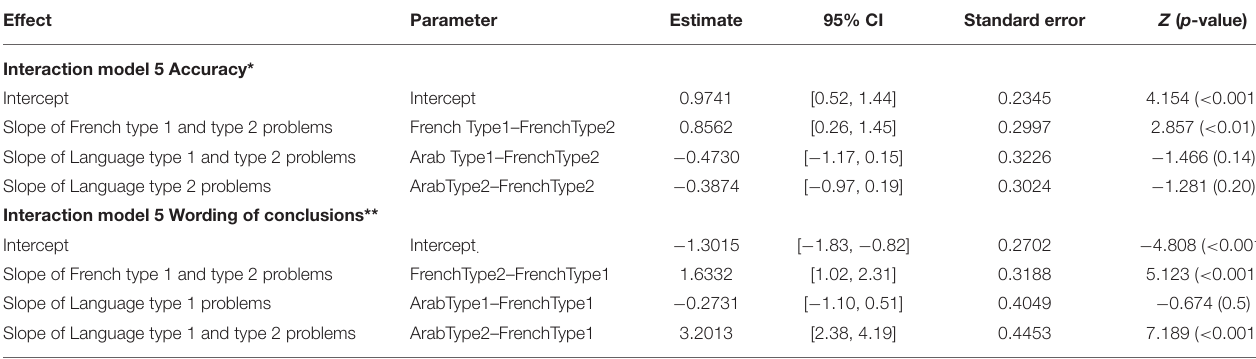
TABLE 4 | Parameters estimates of the interaction of model 5 for Accuracy and the interaction of model 5 for Wording of